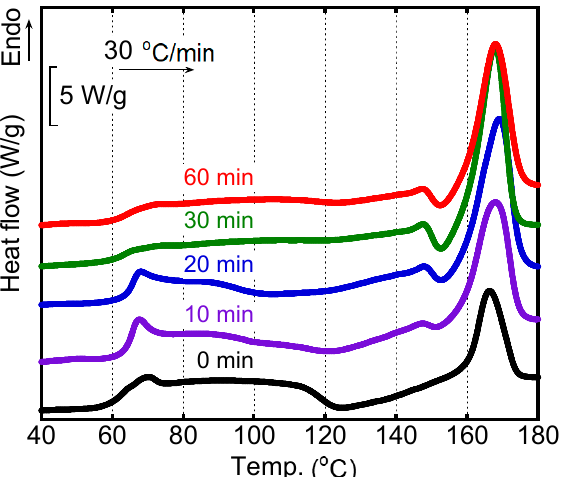
Figure 6. DSC heating curves of the sheared films after annealing at 80 °C for various periods. The heating rate was 30 °C/min.